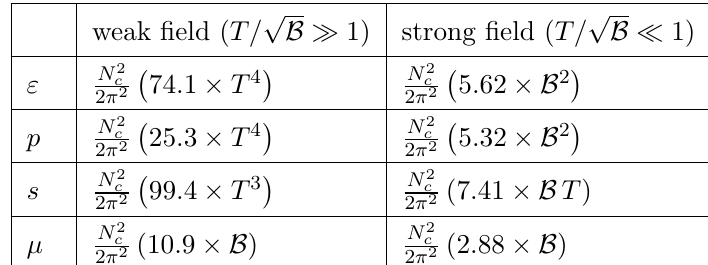
Figure 1 . Dimensionless energy density "= B 2 (top-left), pressure p= B 2 (top-right), entropy density s= B 3 = 2 (bottom-left) and chemical potential (cid:22)= B (bottom-right), in units of N 2 a function of the dimensionless parameter T= both axes.